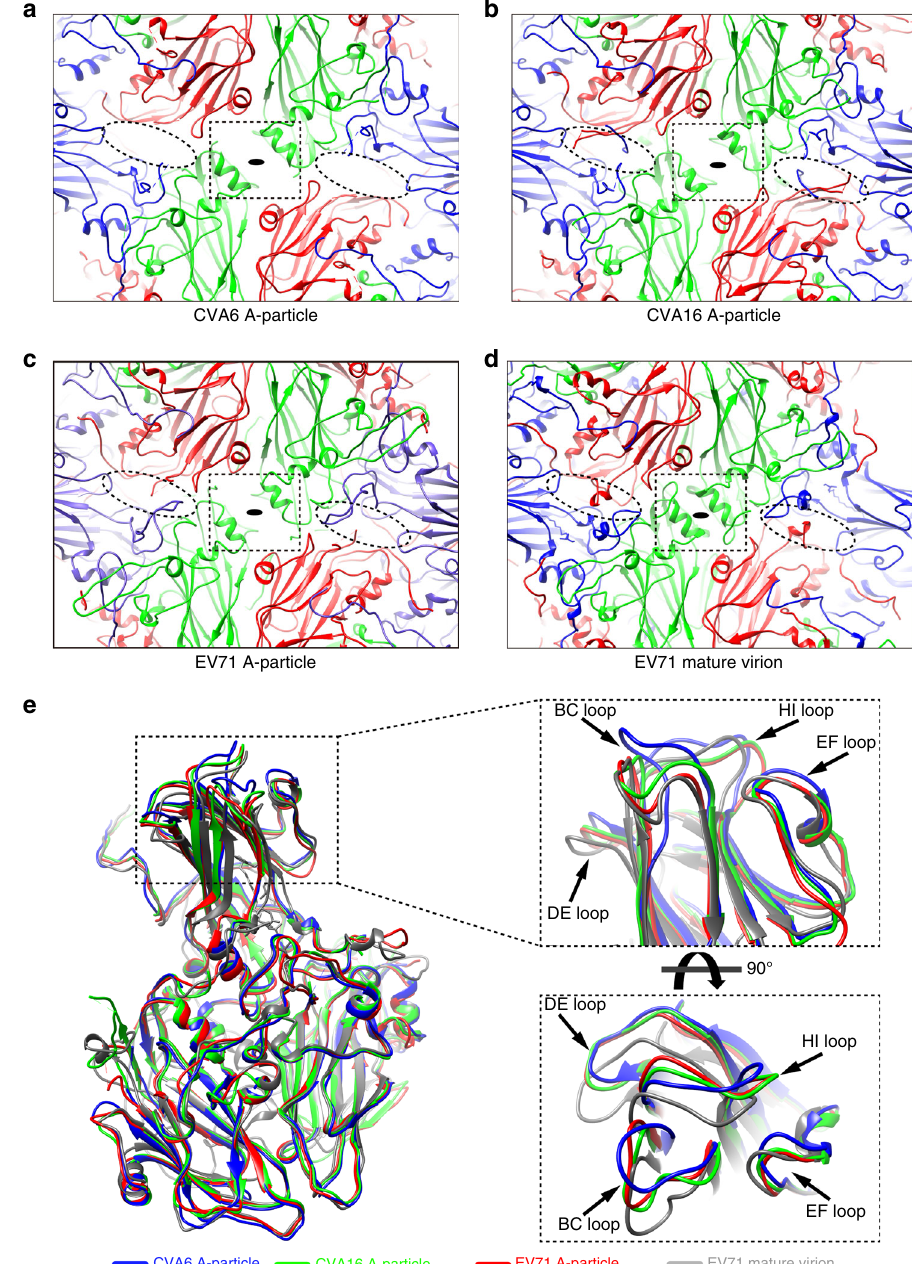
Fig. 3 Structural comparisons of CVA6, CVA16, and EV71. a – d Close up views centered at a 2-fold axis ( black ellipses ) of atomic models of CVA6 A-particle a , CVA16 A-particle b , EV71 A-particle c , and EV71 virion d . The 2f-channels ( dashed squares ) appear wide a , b , narrow c , and closed d . These comparisons also demonstrate that the q3f-channels ( dashed ellipses ) are un-obstructed a , obstructed b , c , and closed d . e Superposition of VP1 surface loops of CVA6 A-particle, CVA16 A-particle, EV71 A-particle and EV71 mature virion. All four of these loops, especially the BC loop, exhibit prominent differences among the different